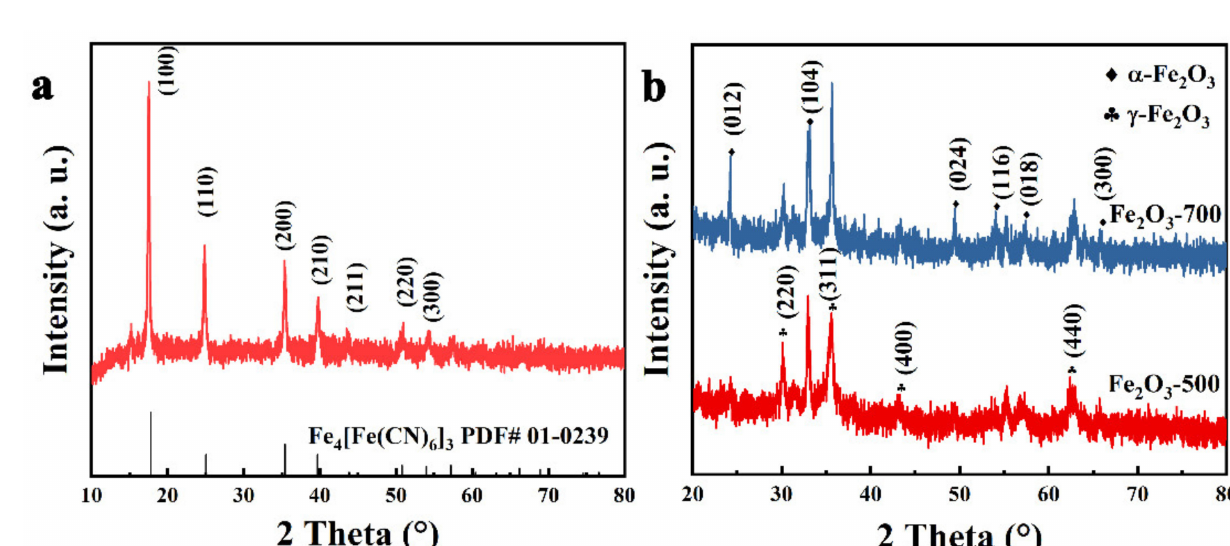
Figure 2. XRD patterns of ( a ) precursors blue and ( b ) Fe 2 O 3